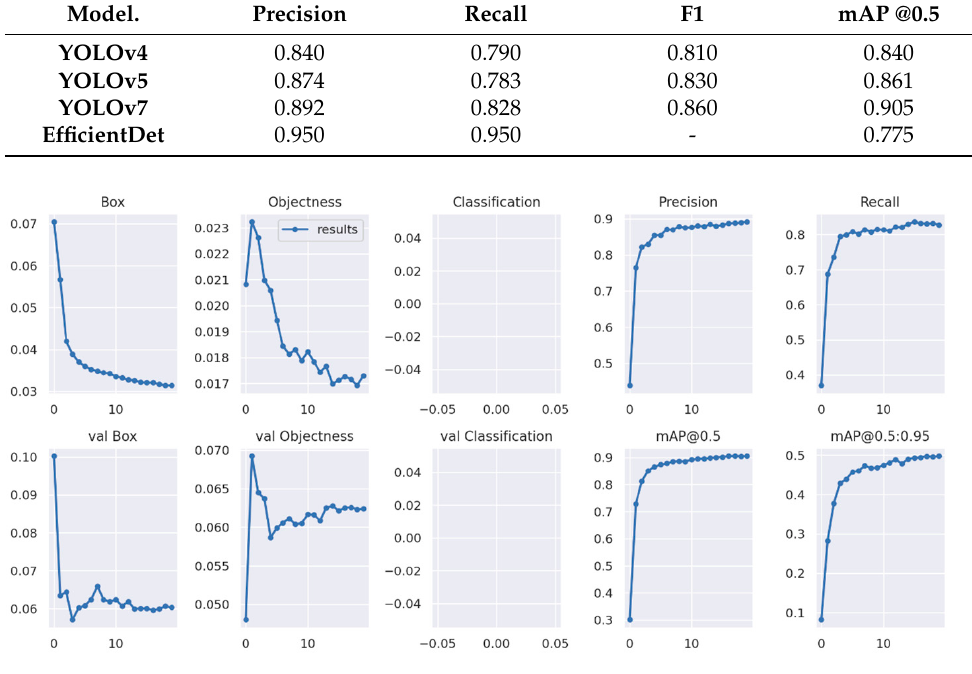
Figure 17. Training performance of datasets using the YOLOv7 algorithm.